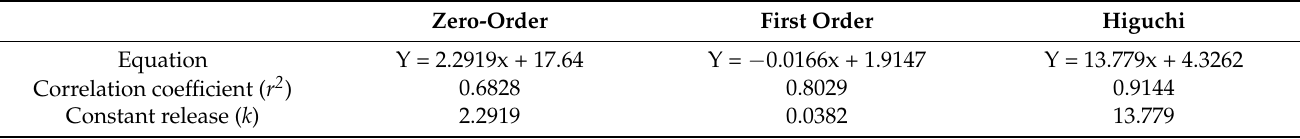
Table 3. Kinetics parameters obtained from the nanoparticles release